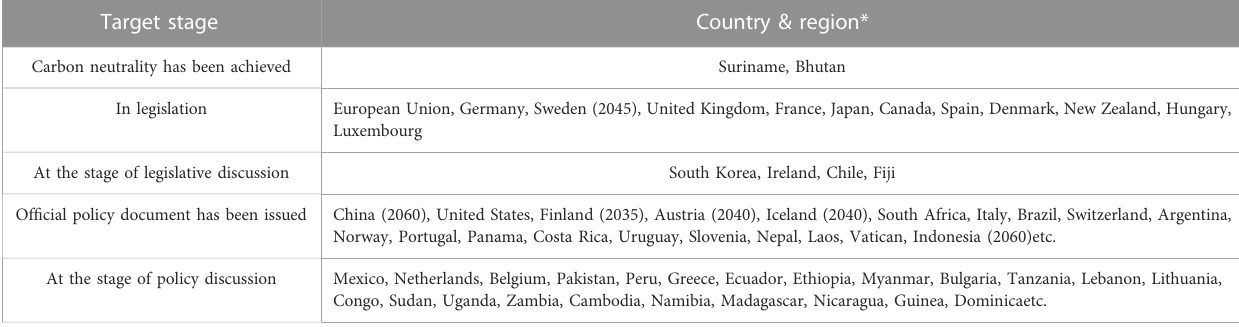
TABLE 1 Development of carbon neutrality targets of countries and regions.